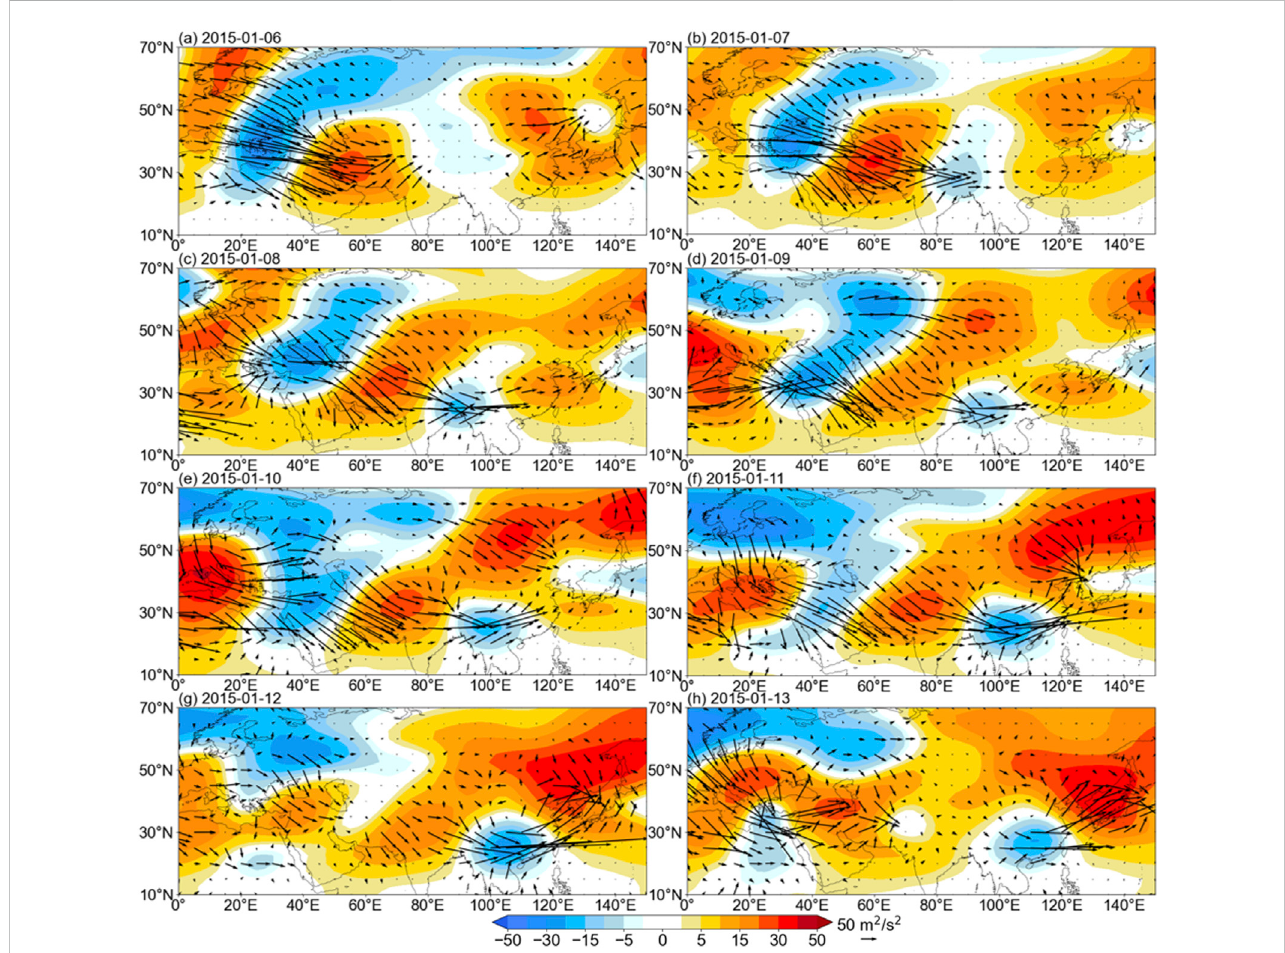
FIGURE 9 Waveactivity fl ux(vectors;units:m 2 · s − 2 )andgeopotentialheightanomalies fi eld(shading;units:10 gpm)at250 hPaonJanuary (A) 6, (B) 7, (C) 8, (D) 9, (E) 10, (F) 11, (G) 12 and (H) 13 in